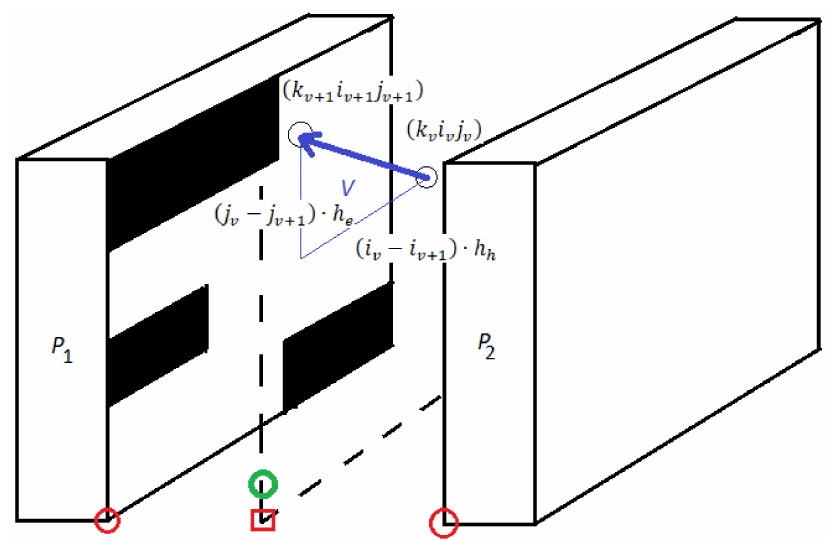
Figure 7. Compartment to compartment. The green circle is the start position of the examination; the blue line is the route of drone; the red square is the center of the corridor (reference point). The red circles are referece points. (source: self-edited